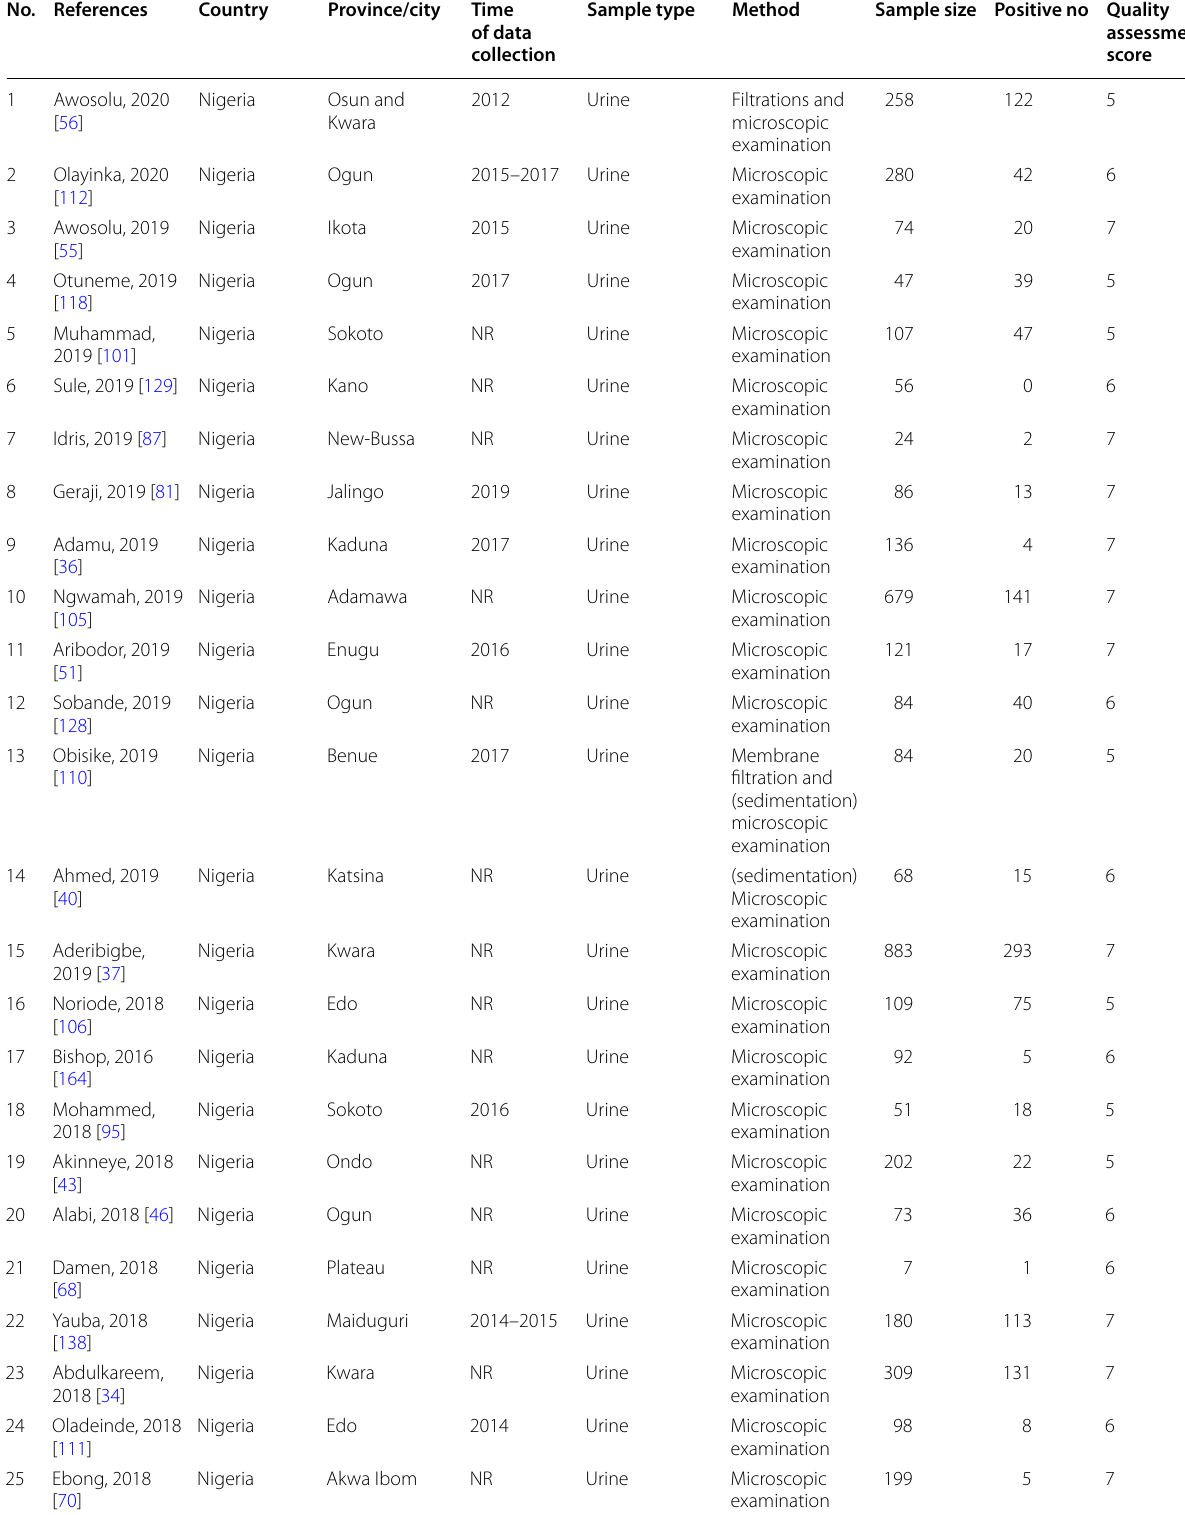
Table 1 Detailed characteristics of the included studies in the present systematic review and meta-analysis